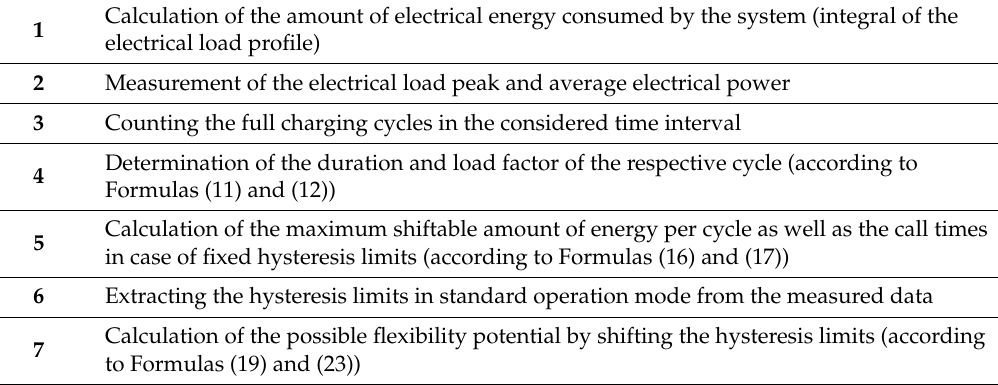
Table 2. Work steps carried out in the case study.